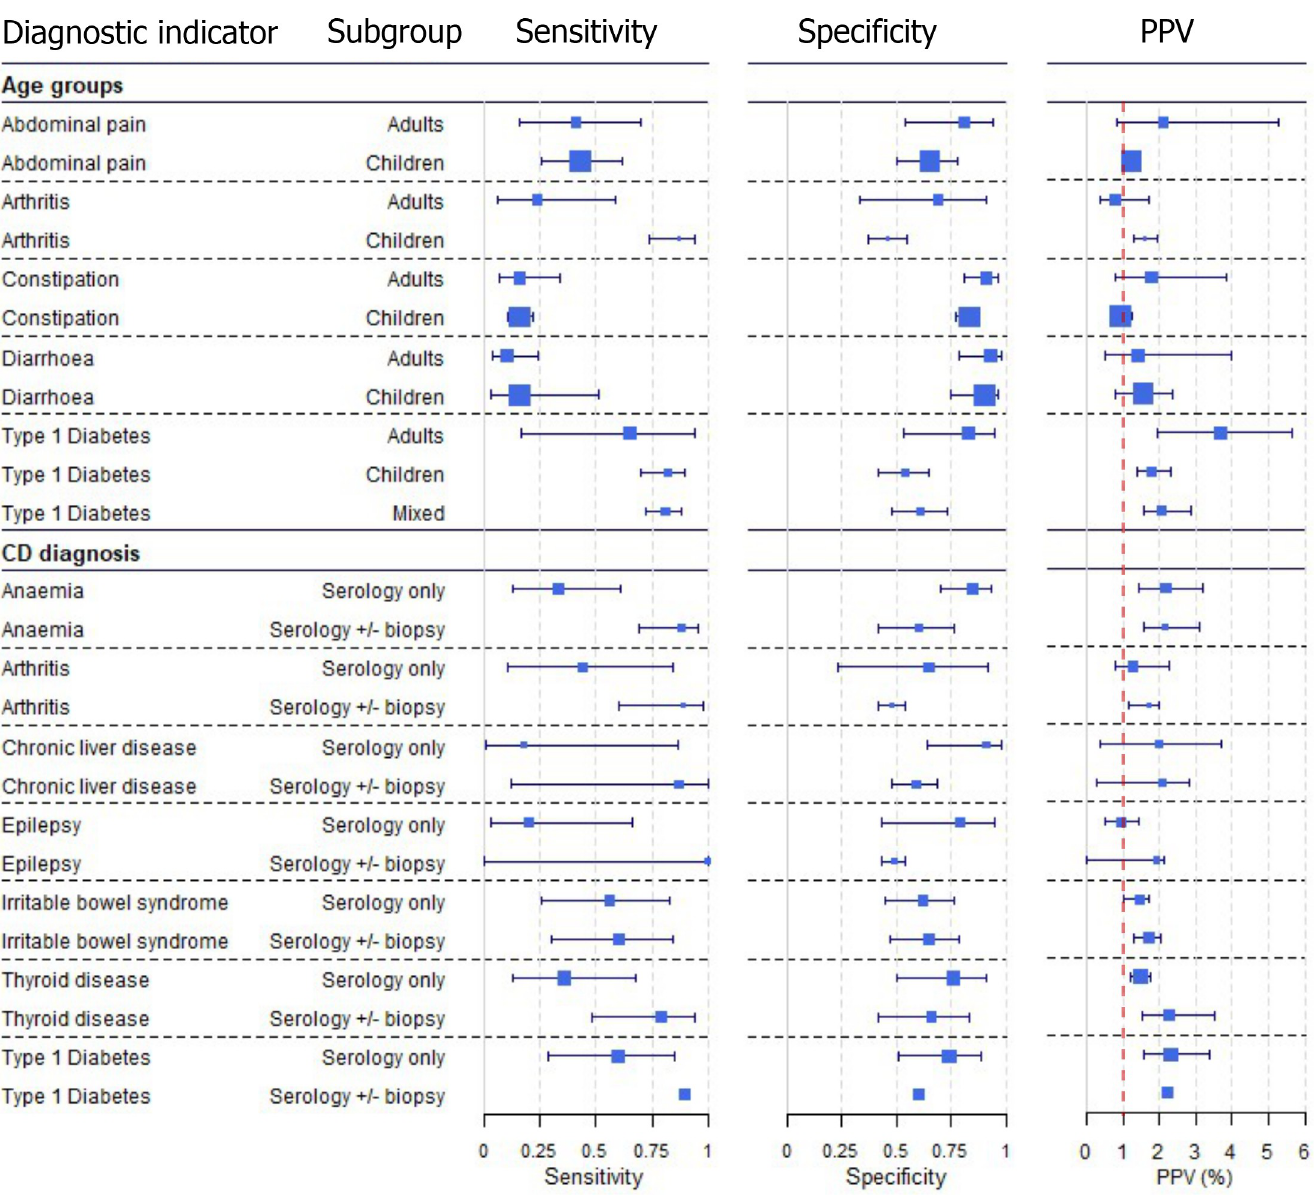
Fig 4. Subgroup analysis stratified by age group and CD diagnosis. Stratified meta-analysis results are shown per diagnostic indicator. Positive predictive values (PPVs) were calculated for a population with a CD prevalence of 1% (red dotted line) using the estimated sensitivities and specificities from the meta-analyses. The area of the box size is proportional to the total number of